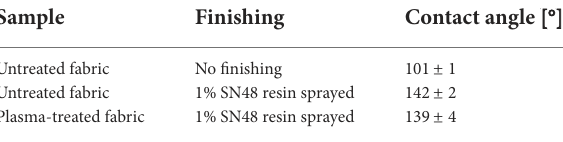
TABLE 1 Water droplet contact angles measured for treated and untreated cashmere fabrics. Sample